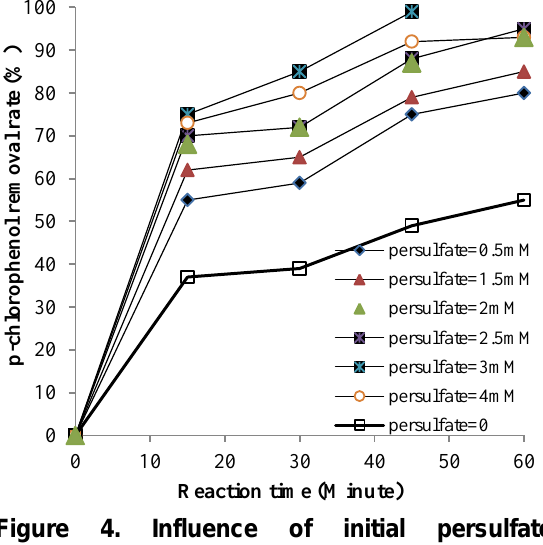
Figure 4. Influence of initial persulfate concentration on the degradation of p-chlorophenol Initial experiment conditions: pH = 3, zerovalent iron = 1 mM, p-chlorophenol = 0.44